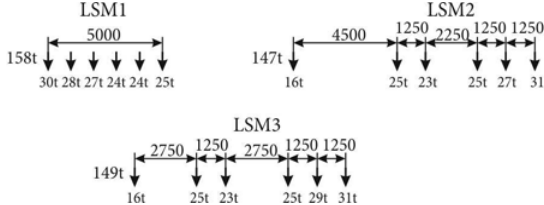
Fig. 6. Most important integrated traffic load models based on actual traffic loads in Latvia